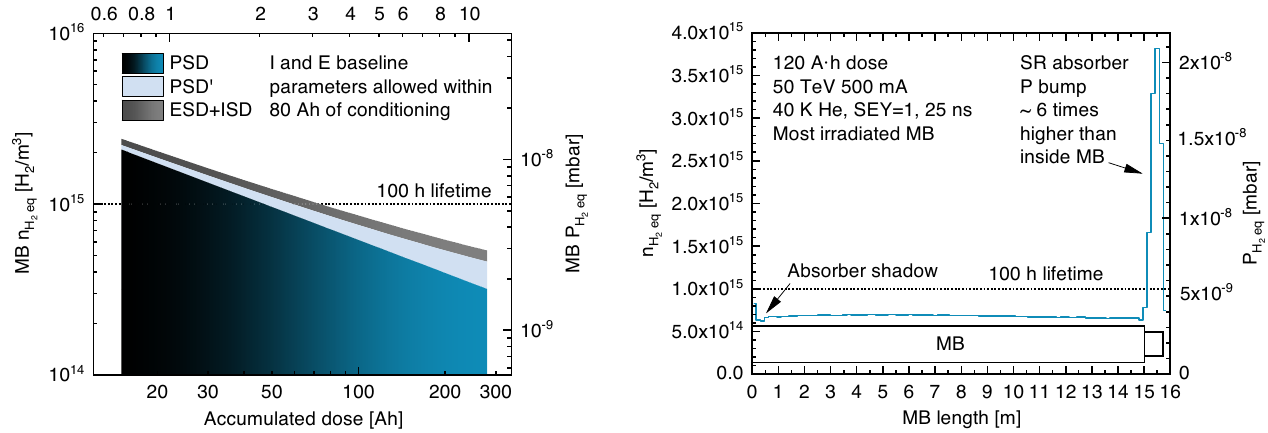
FIG. 12. On the left, n is plotted in H 2 units over the accumulated photon dose and its equivalent time in months for 30 mA of eq H 2 eq average current. On the right, the n profile of the most irradiated MB in the arc cell, representing the periodic profile in the arcs. It is H 2 eq characterized for the bump in the interconnection area, with no cryopumping present for most gas species. Values given for 50 TeV, 500 mA, LASE with an SEY ¼ 1 . 0 and Cu with a SEY ¼ 1 . 4 , for both